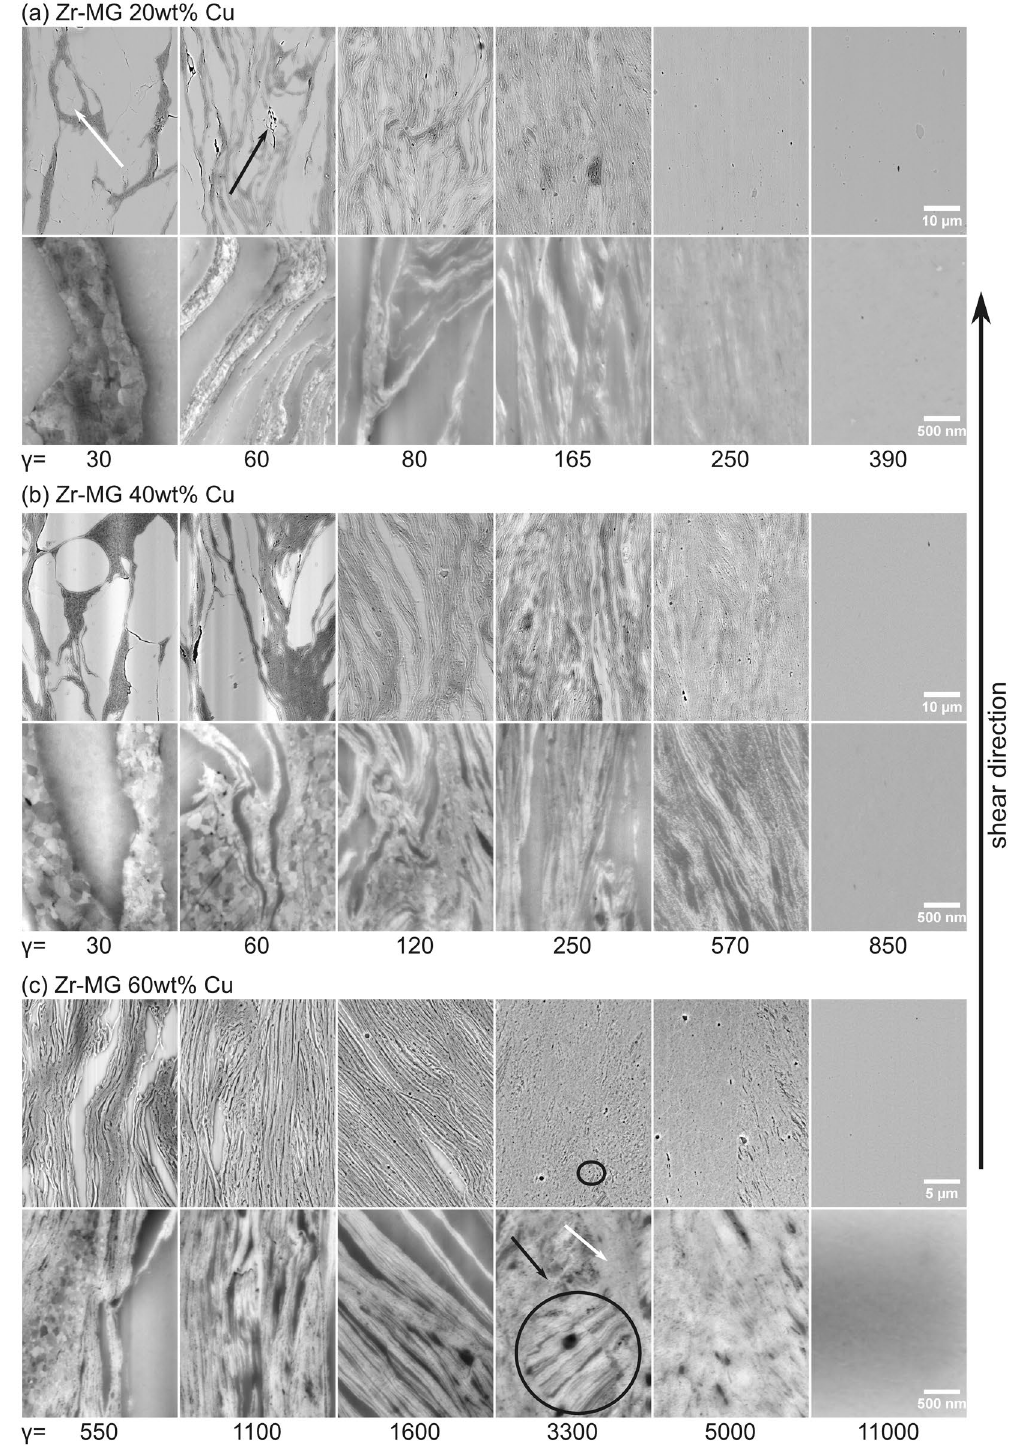
Figure 1. Illustration of SEM micrographs of ( a ) Zr-MG 20 wt% Cu, ( b ) Zr-MG 40 wt% Cu, and ( c ) Zr-MG 60 wt% Cu. The top and bottom row of micrographs are taken at different magnifications. The evolution of the microstructure can be seen in dependence of the applied strain. The deformation increases from the left to the right and the microstructure changes from Zr-MG particles glued together by crystalline Cu to a lamellar structure. These lamellae refine with increasing applied strain until a complete mixing of the two phases occurs. Take notice in the increase of applied strain at higher contents of